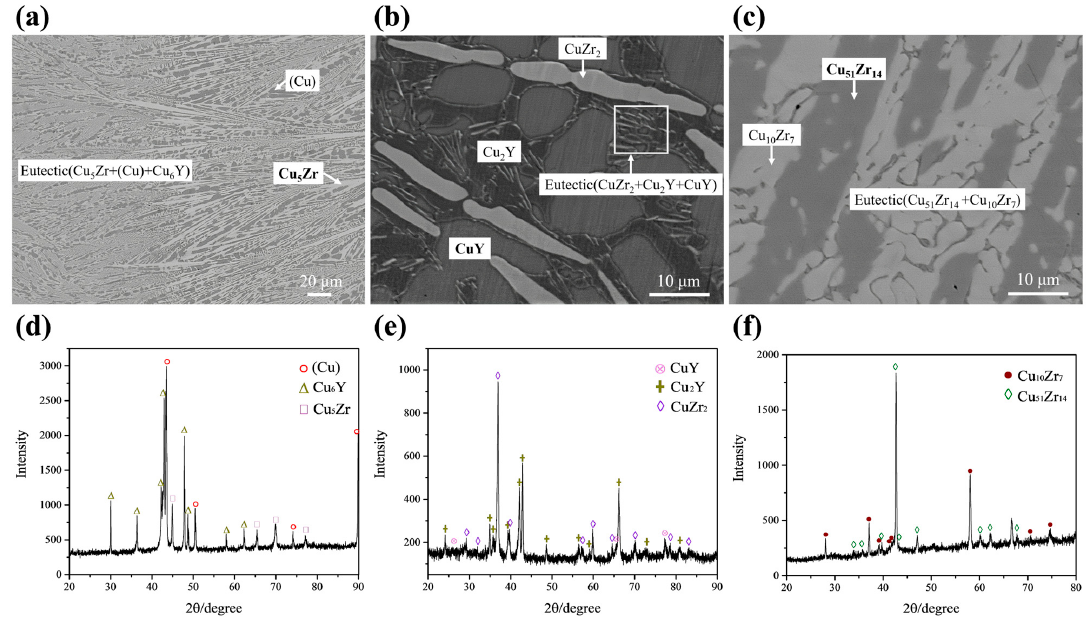
Figure 4. BSE micrographs and XRD patterns of as-cast alloys: ( a , d ) A1 Cu 90 Zr 8 Y 2 (at.%); ( b , e ) A9 Cu 53 Zr 12 Y 35 (at.%); ( c , f ) A12 Cu 66 Zr 32 Y 2